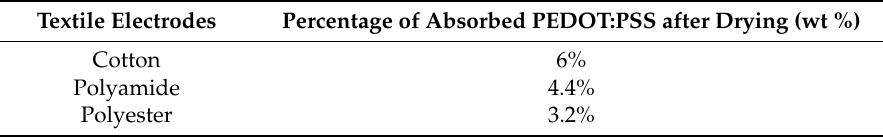
Table 1. Mass weight percentage of PEDOT:PSS after